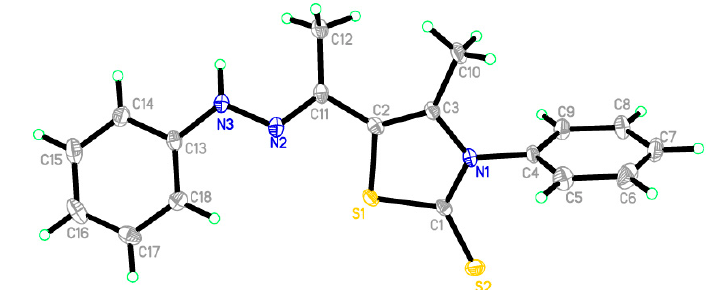
Figure 1. ORTEP diagram of the thiazoline 5c . Displacement ellipsoids are plotted at the 40% probability level for non-H atoms.